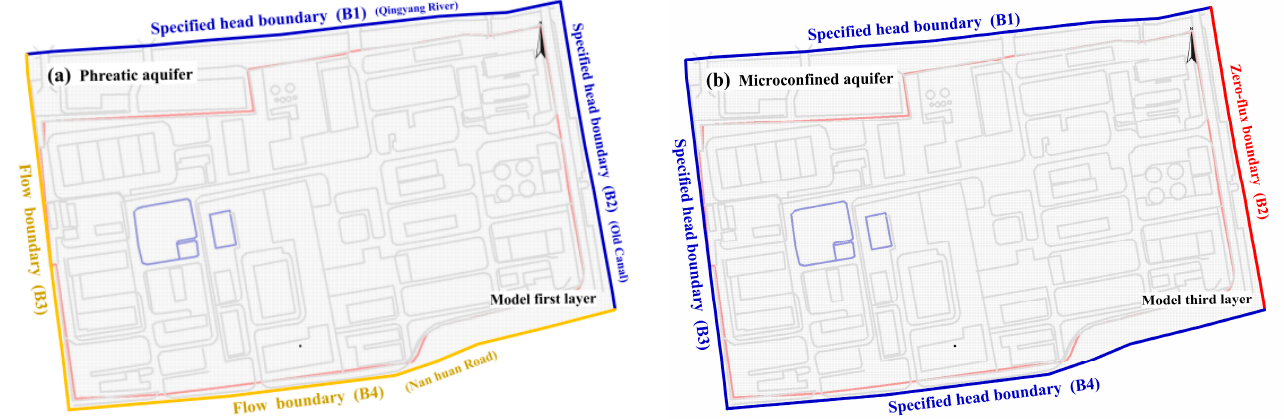
Figure 4. Generalization and se tt ing of model boundary